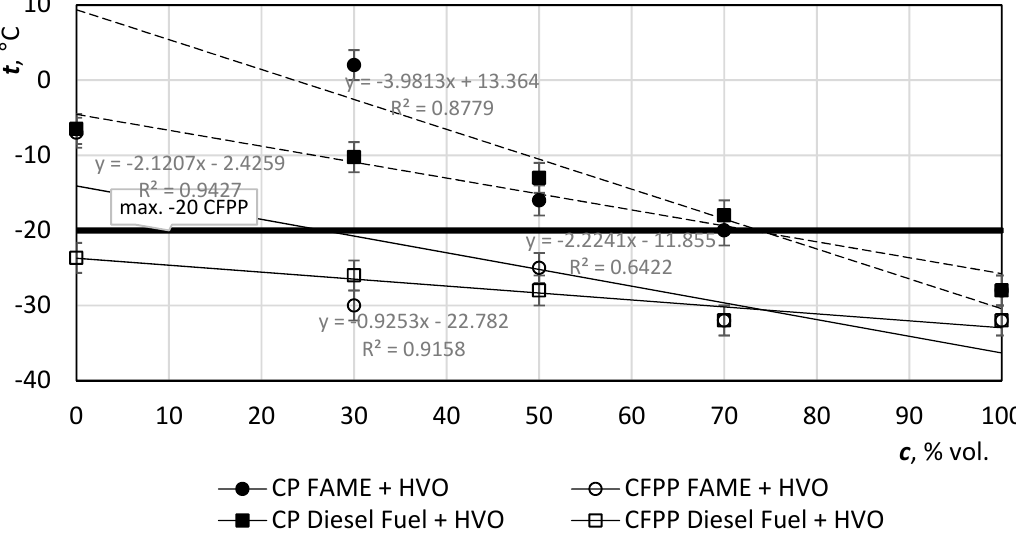
Figure 9. CFPP and cloud point (CP) of mineral diesel fuel with FAME and HVO.